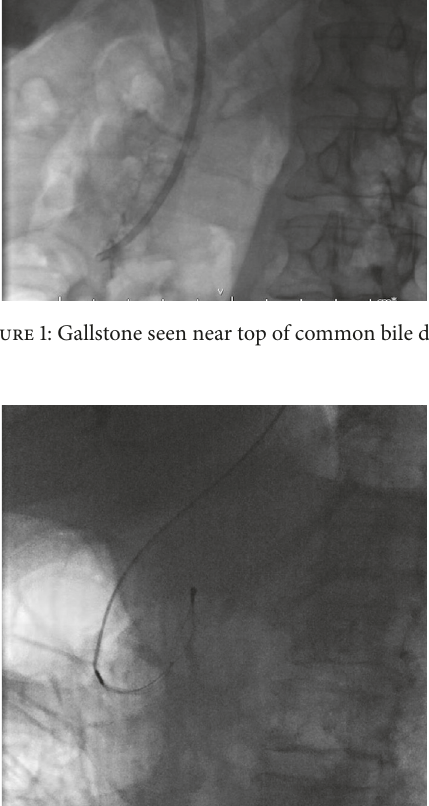
Figure 4: Debulked ERCP Dormia basket now collapsed and ready for removal, with few remaining stone